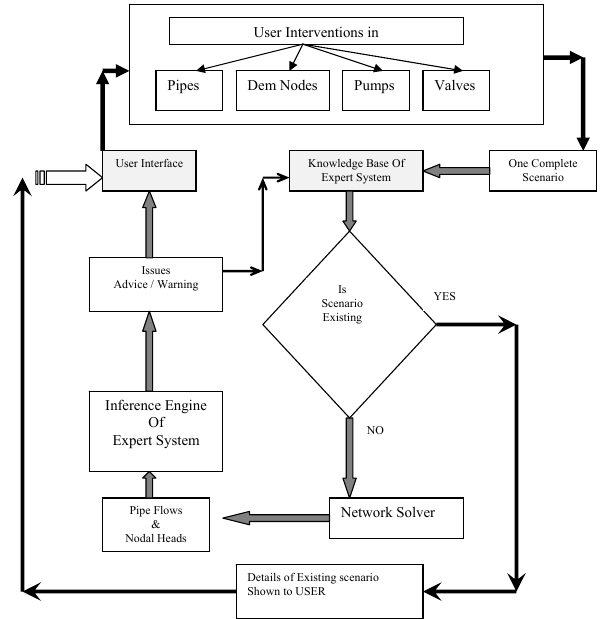
Figure 5. Schematic of calibration module. Fig. 5. Schematic of Calibration Module Fig. 5. Schematic of Calibration Module